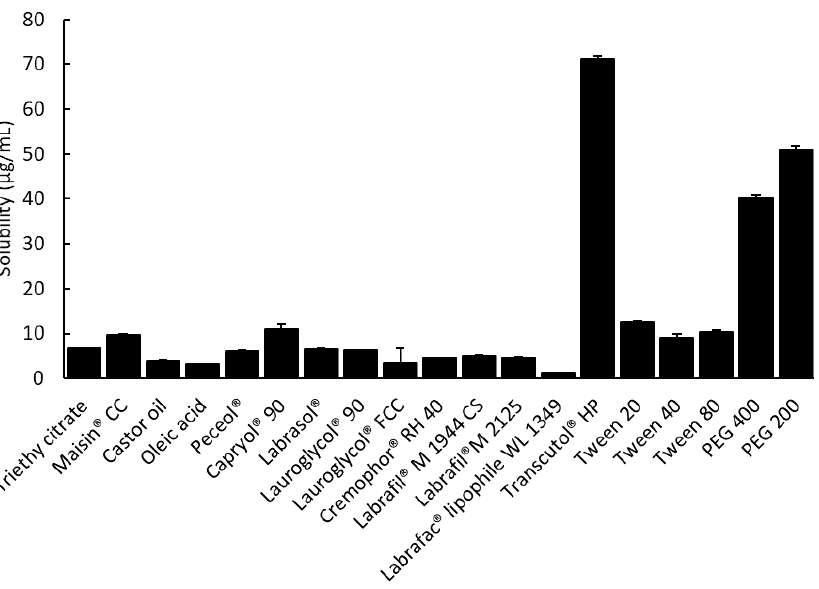
Figure 1. The solubility of tolvaptan in various excipients at 37 ± 0.5 °C (mean ± SD, n = 3).